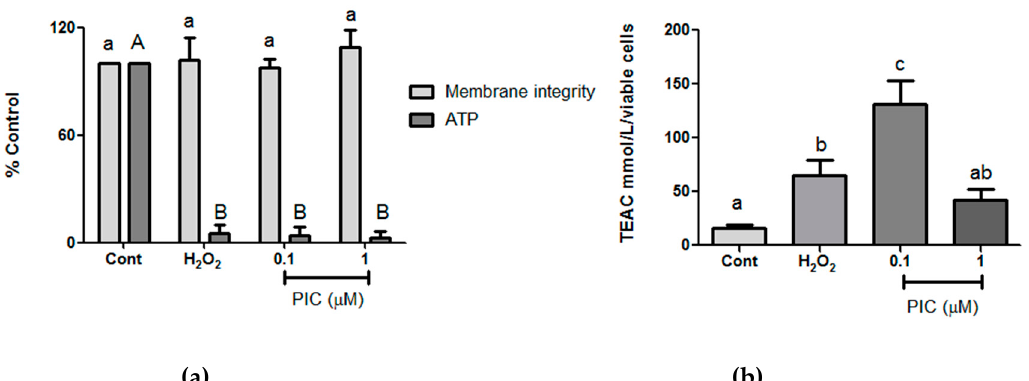
Figure 4. ( a ) Cell membrane integrity and ATP production and ( b ) total antioxidation capacity after 1-h treatment with hydrogen peroxide (H 2 O 2 ) (200 μ M) and different concentrations of piceatannol (Pic). The results are expressed as mean ± SD. Statistical differences between treatments at the same analysis were shown by lower case (a–c) and upper case (A–B) on graph ( p ≤ 0.05).